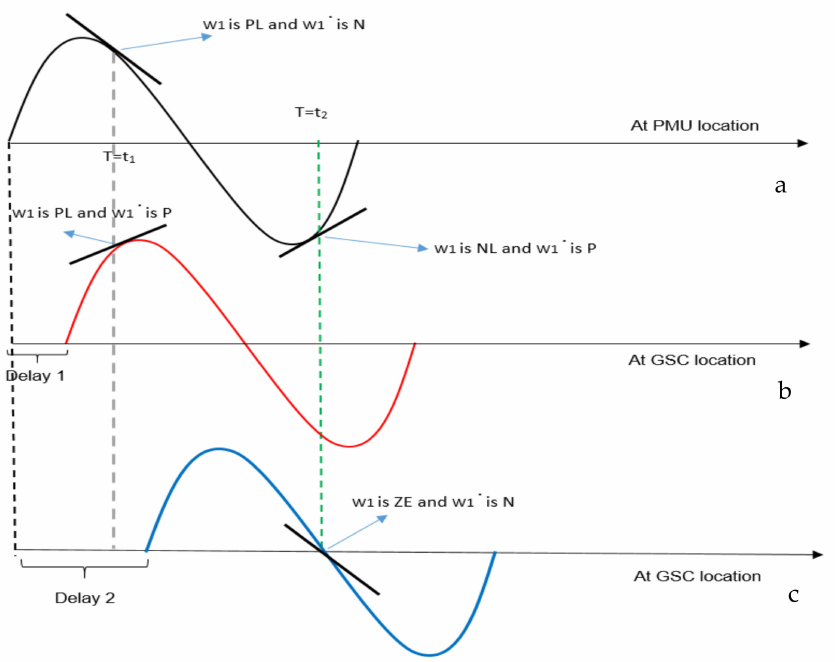
Figure 12. Time delay signal of w1, ( a ): PMU location without delay; ( b ): GSC location with medium time delay; ( c ): GSC location with large time